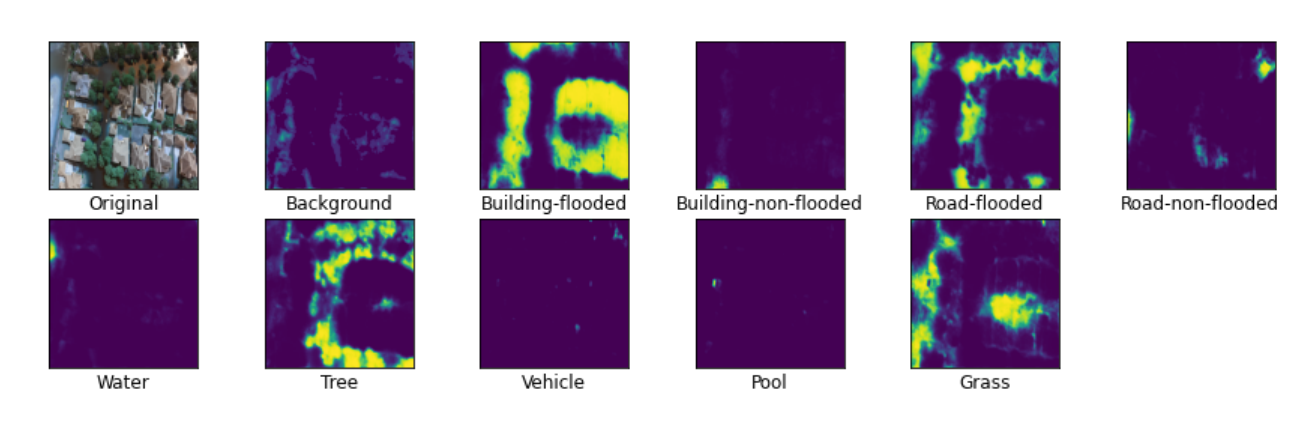
Figure 5. Segmentation mapping of each of the classes on the original photo.